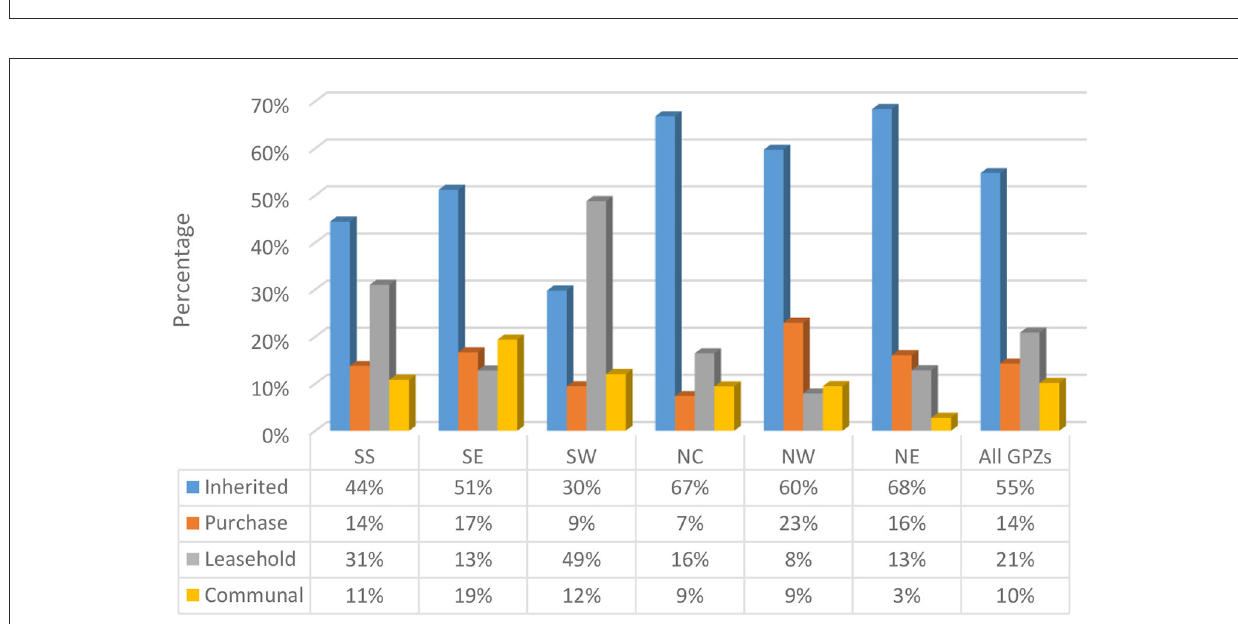
FIGURE4 Tenure type by geopolitical